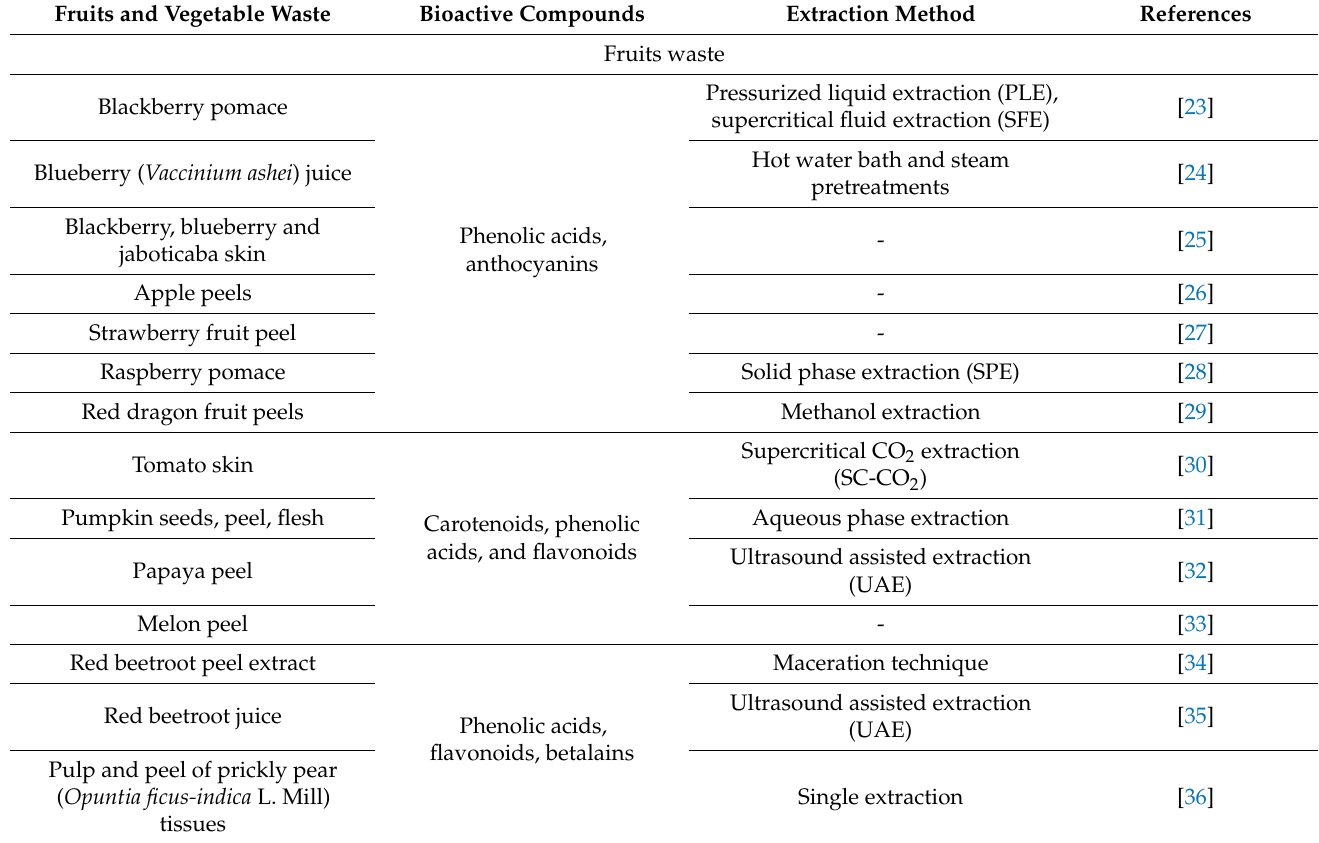
Table 1. Bioactive compounds from fruit and vegetable